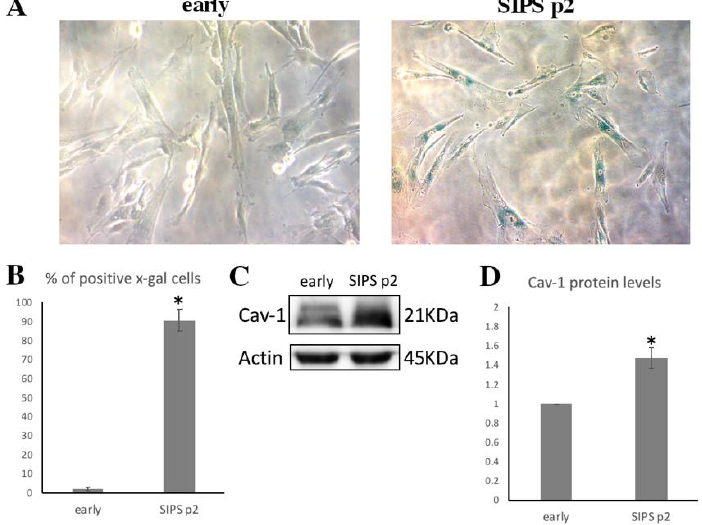
Figure 5. Cav-1 levels increase in SIPS. ( A ) Representative photos of early passage (early) cells untreated (early) and after being subjected to stress induced premature senescence (SIPS) by treatment with 400 µ M of H 2 O 2 , 2 h at passage 2 (SIPS p2) stained with SA- β -gal staining solution. ( B ) Graph showing the percentage of SA- β -gal positive cells in early and SIPS p2 cells. Values shown are the means ± S.E. * p < 0.05 vs. early passage WJ-MSCs. ( C ) Characteristic immunoblot showing caveolin-1 (Cav-1) levels increasing significantly in SIPS p2 cells. Antibody against β -Actin was used as loading control. ( D ) Graph demonstrating Cav-1 levels in early and SIPS p2 cells, based on band density calculated using Image J. Values shown are the means ± S.E. * p < 0.05 vs. the early passage WJ- MSCs .